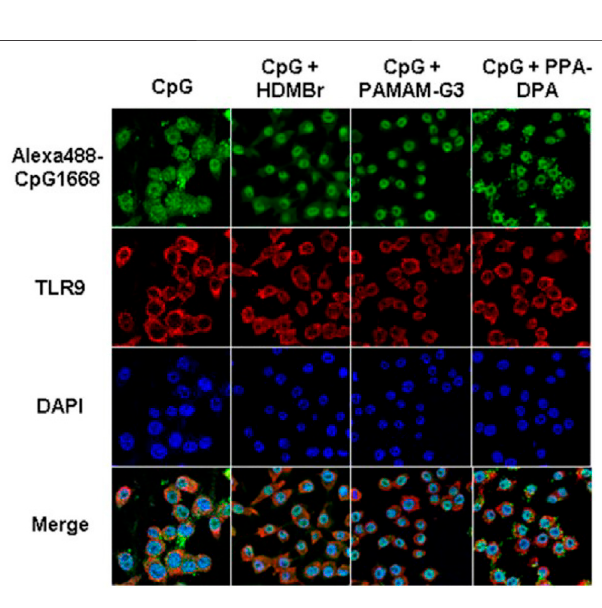
FIGURE4| PAMAM-G3, HDMBr, and PPA-DPA altered the uptake and intracellular distribution of immune stimulatory nucleic acids (Reprint from Reference (Lee et al.,